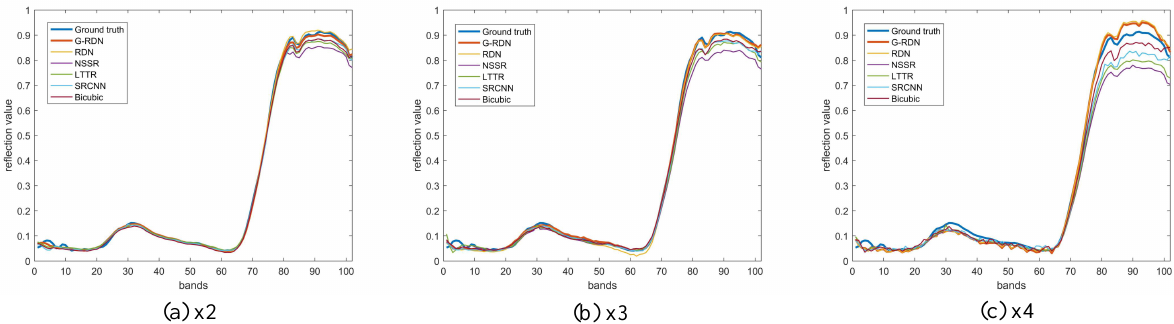
Figure 12. Visual exhibition of the spectral curves of a randomly selected pixel in the reconstructed Pavia